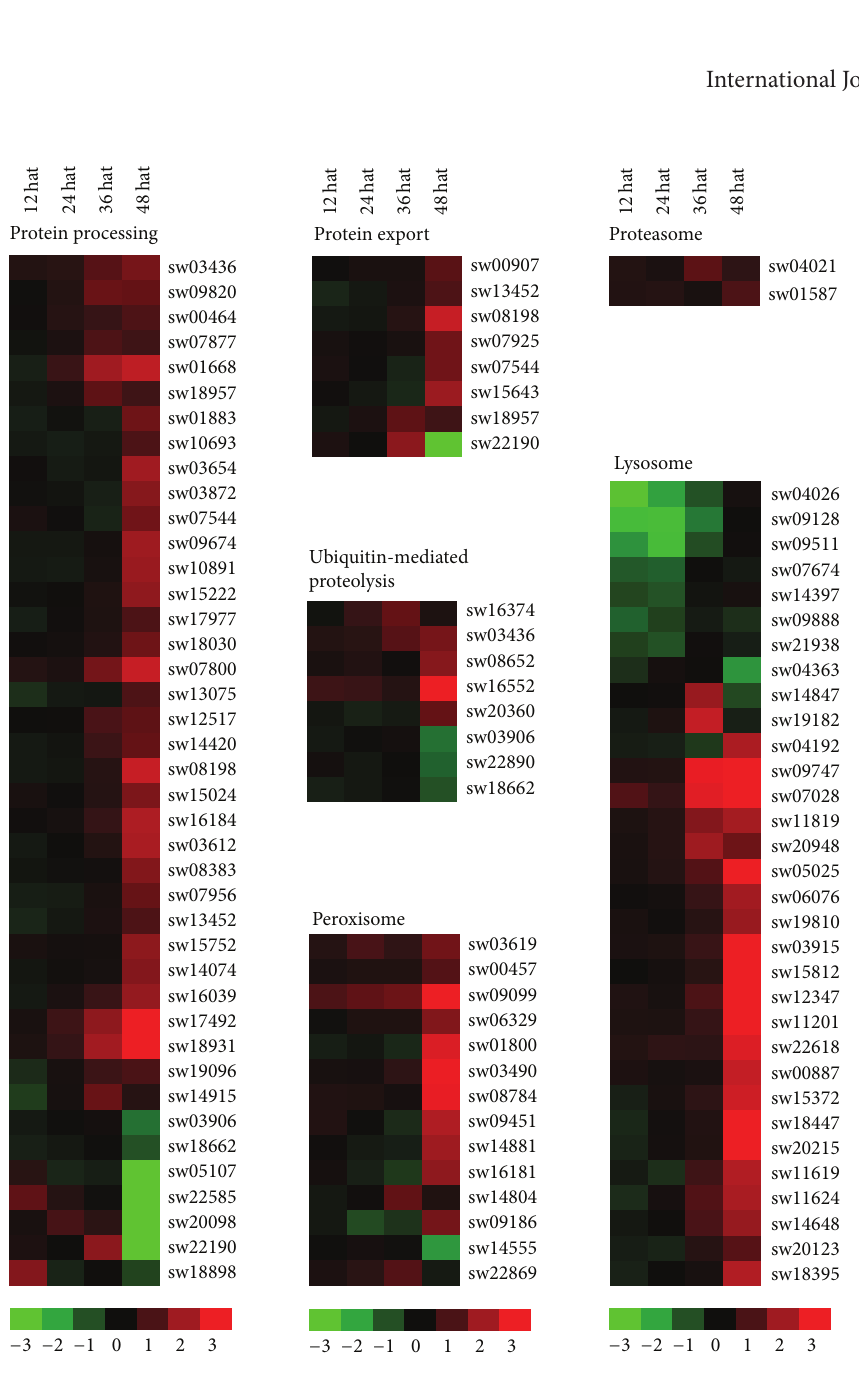
Figure 6: JHA-modulated pathways involved in protein synthesis and degradation. Hierarchical clustering of JHA-modulated genes involved in six pathways related to protein synthesis and degradation, including protein processing, protein export, ubiquitin-mediated proteolysis, proteasome, lysosome, and peroxisome. The probe ID, KEGG ID, and expression intensity of each JHA-modulated gene are listed in Tables S5 and S8. Hat: hours after